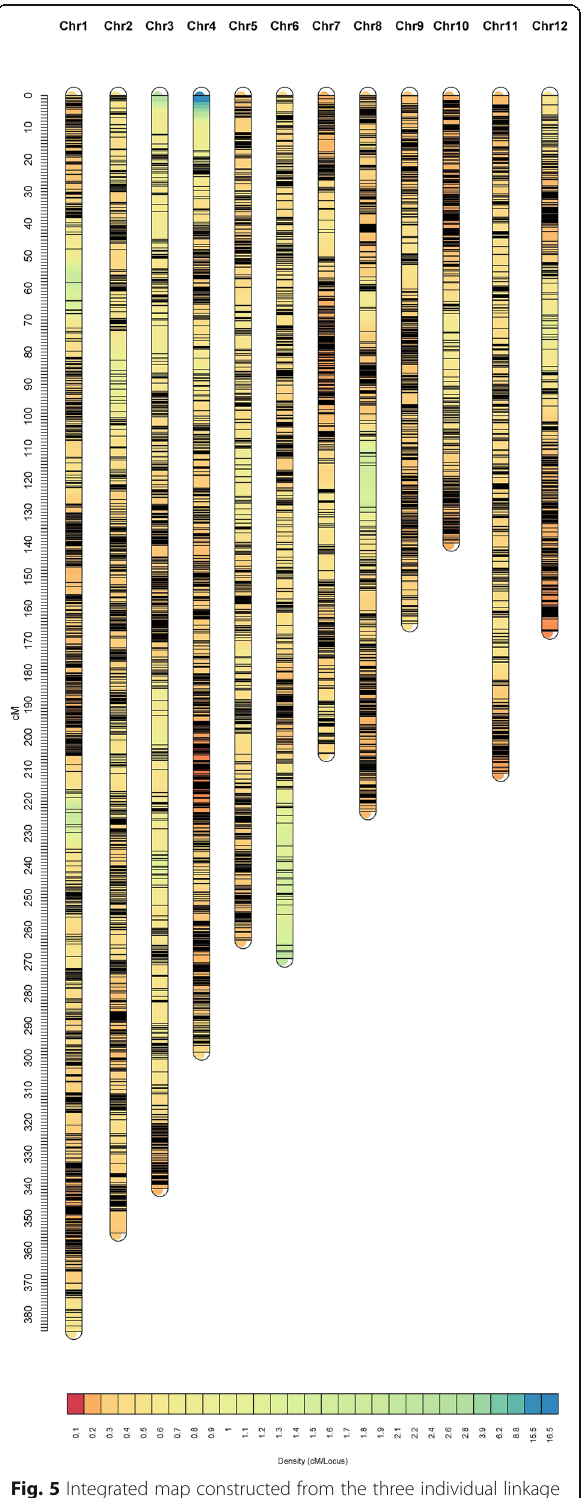
Fig. 5 Integrated map constructed from the three individual linkage maps for 8PL, 4PL1 and